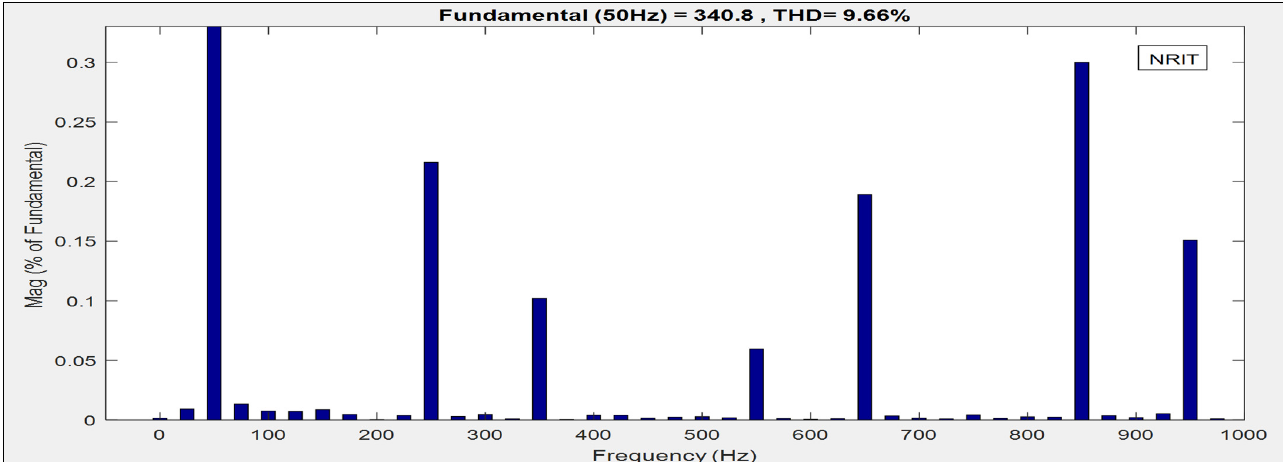
Figure 18. Case study 2 three-phase grid voltages and current with NRIT.